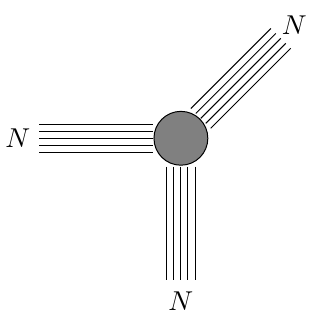
Figure 5 . The N -junction, a ( p; q ) 5-brane intersection with three external 5-brane stacks, obtained by taking N copies of the basic junction of a D5 and an NS5